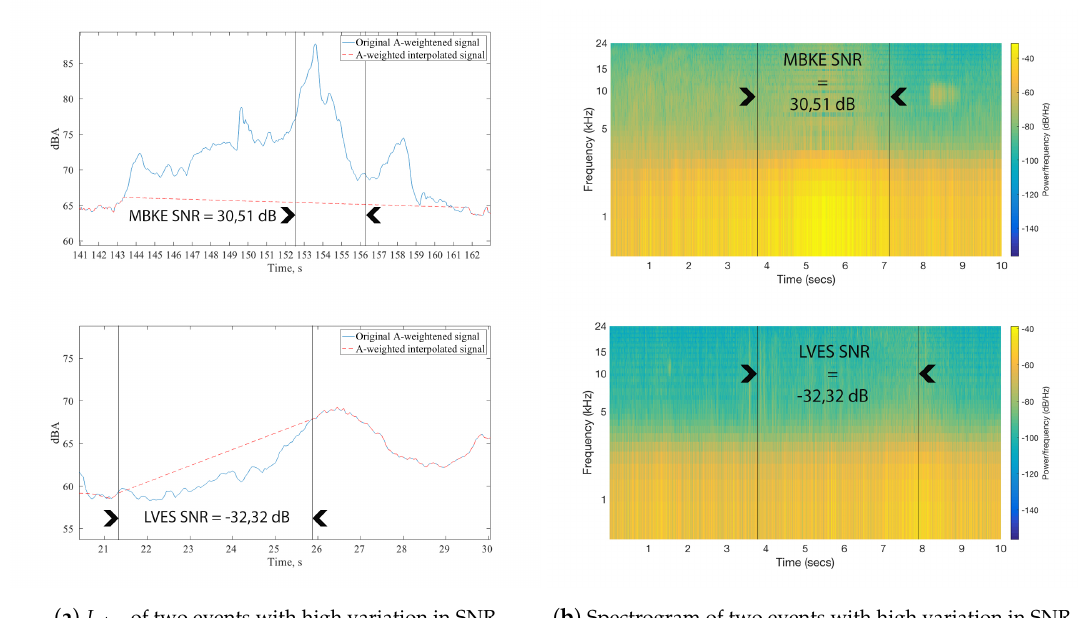
Figure 6. L Aeq and spectrogram of two events with high variation in SNR. The first event belongs to a motorbike recorded during the first day in Location 3 at 08:58 and the second one is associated to dry leaves moved by wind recorded during the first day in Location 1 at 15:20.